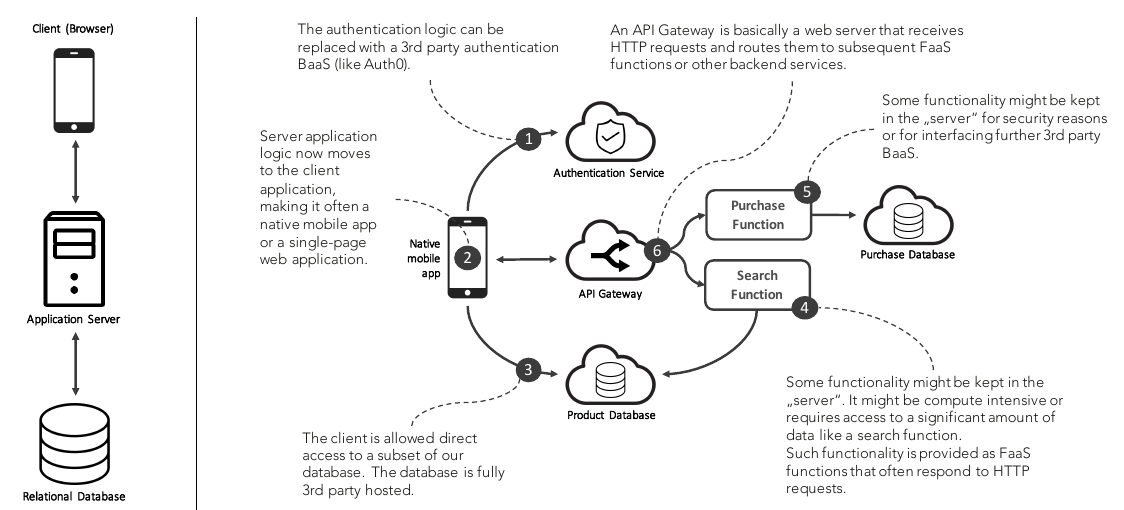
Figure 9. Serverless architectures result in a different and less centralized composition of application components and backend services compared with classical tiered application